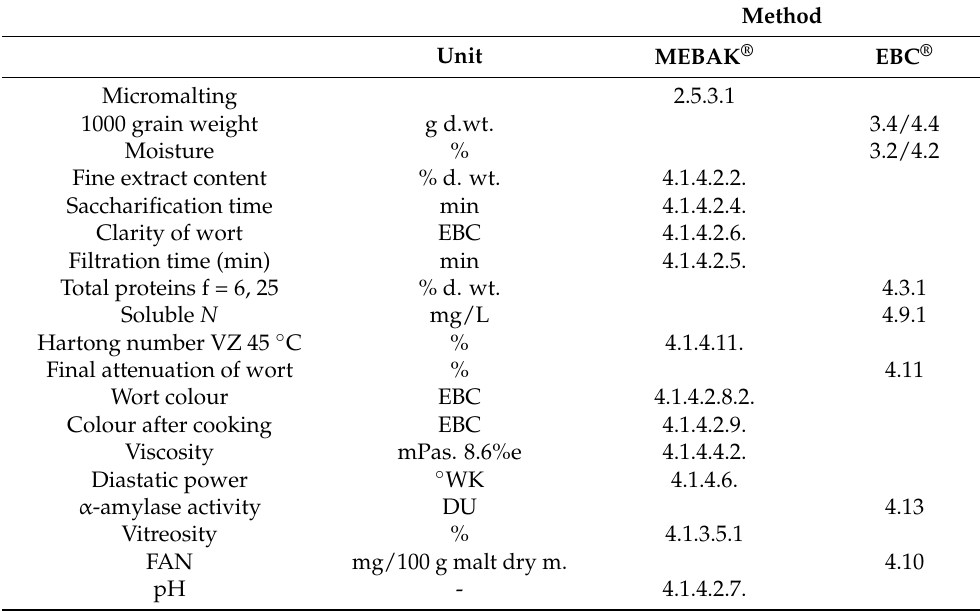
Table 2. Used MEBAK and EBC methods for the analysis of wheat and